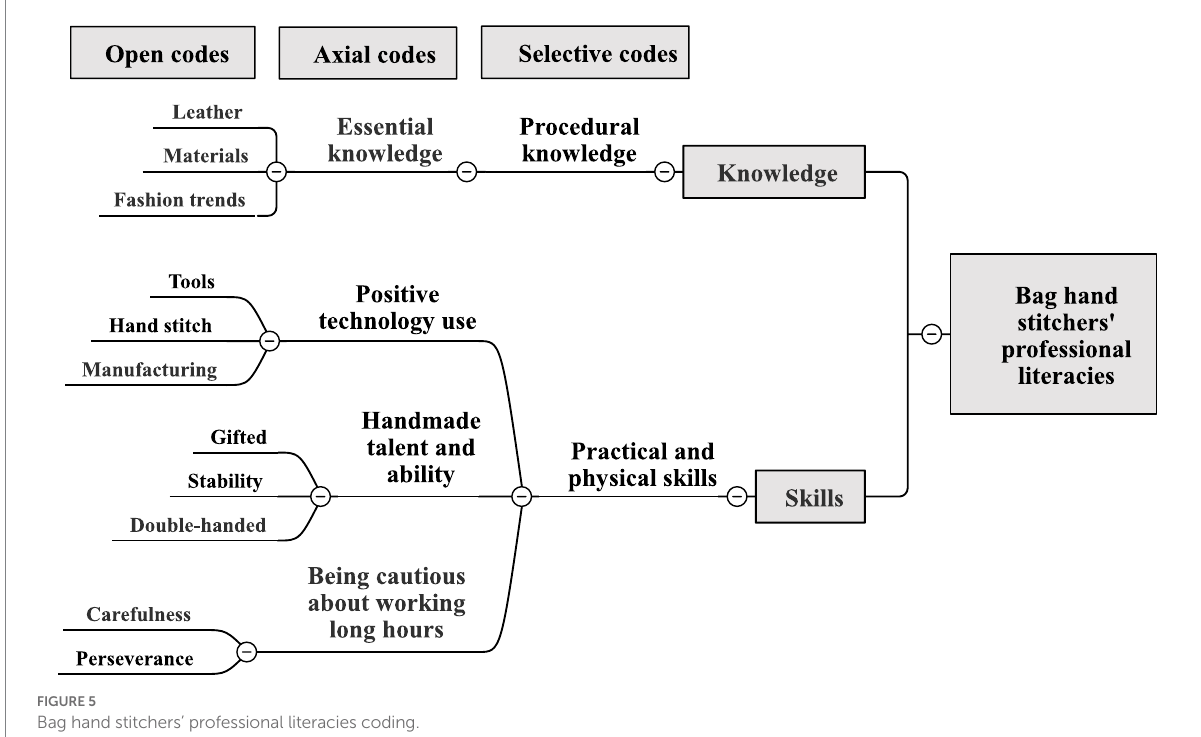
FIGURE 5 Bag hand stitchers’ professional literacies